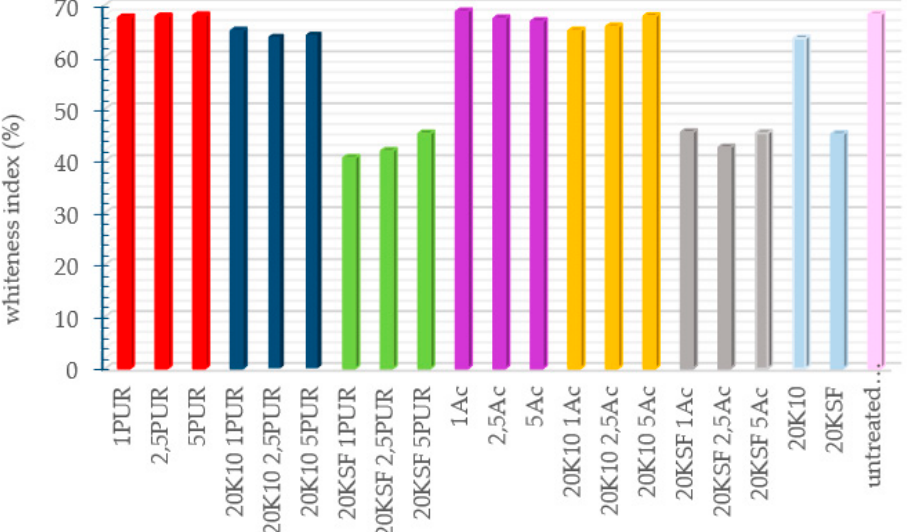
Figure 3. WI CIE results of the treated samples using different formulation.